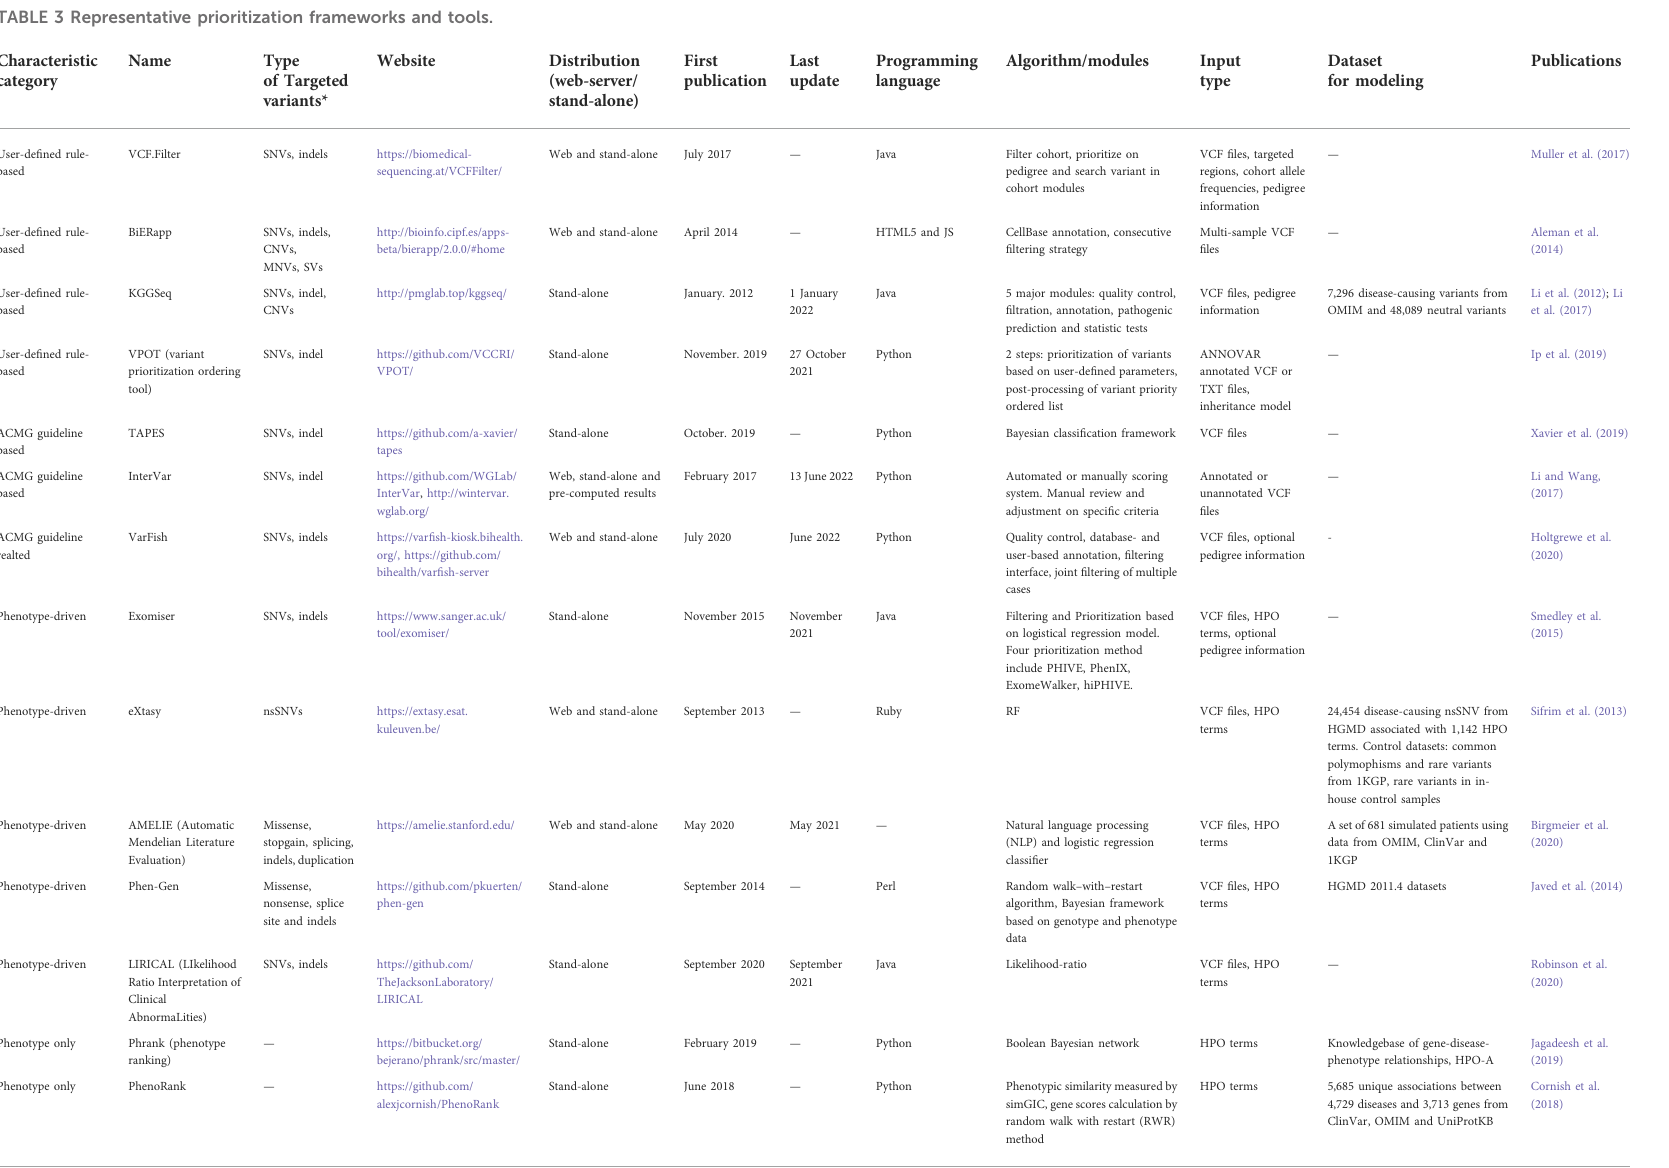
TABLE 3 Representative prioritization frameworks and